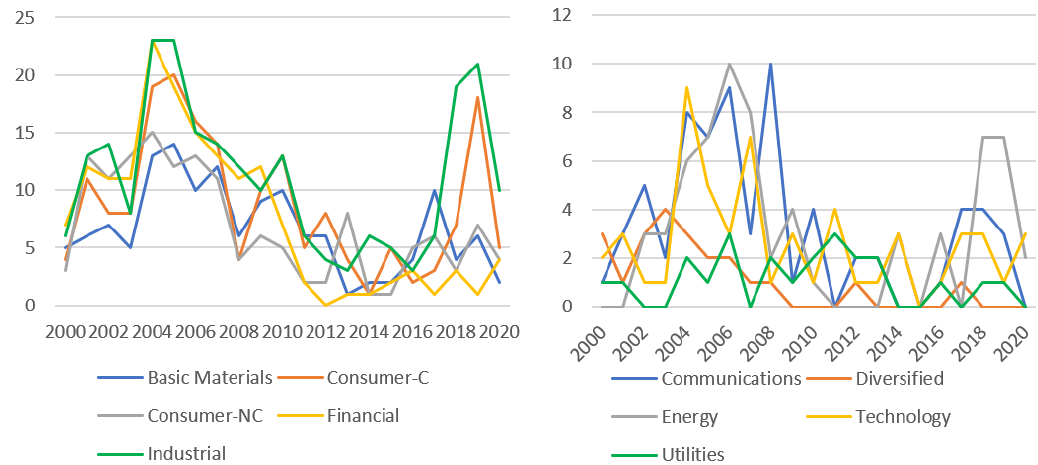
Figure 1. The number of all industry defaults per year. Source: NUS-CRI database.